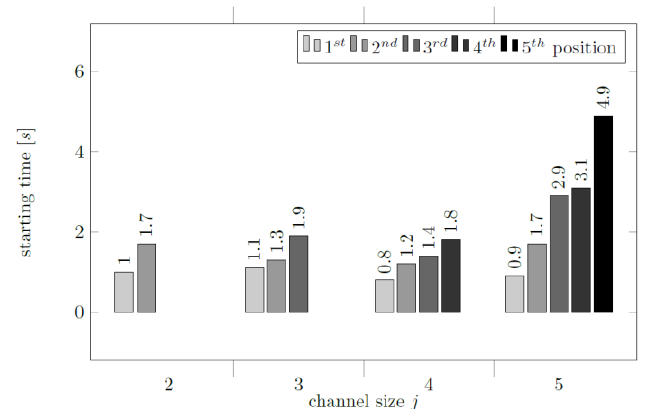
Figure 9. Starting times of consecutive cyclists in channel for various channel